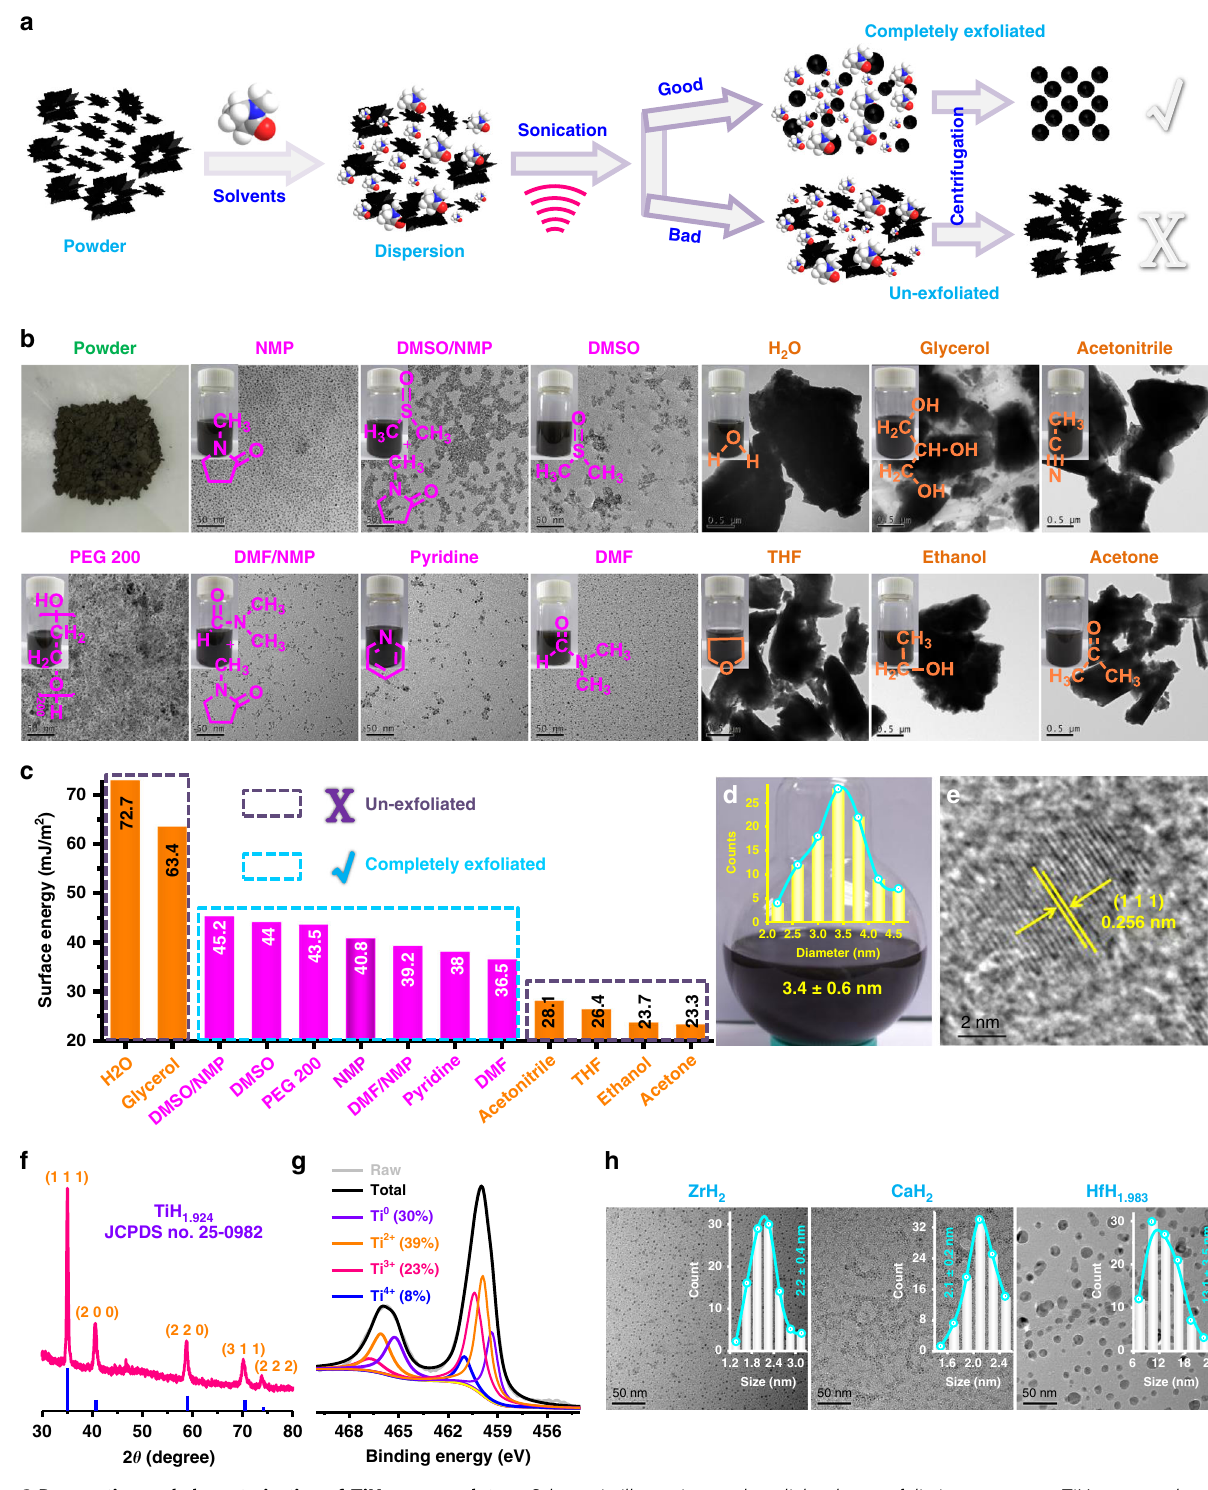
Fig. 2 Preparation and characterization of TiH 1.924 nanodots. a Schematic illustration to show light-phase exfoliation to prepare TiH 1.924 nanodots. b A photograph of commercial TiH 1.924 powder, the TEM images and corresponding photographs of exfoliated dispersions using various solvents (H 2 O, glycerol, dimethyl sulfoxide/ N -methyl pyrrolidone (DMSO/NMP) DMSO/NMP, DMSO, polyethylene glycol 200 (PEG 200), NMP, N,N -dimethylformamide (DMF)/ NMP, pyridine, DMF, acetonitrile, tetrahydrofuran (THF), ethanol, and acetone) for TiH 1.924 exfoliation. c The surface energies of various solvents used to exfoliate TiH 1.924 . d A photograph of exfoliated TiH 1.924 nanodots in NMP. Inset is the particle-size distribution (PSD) of TiH 1.924 nanodots determined by the TEM image ( n = 100 nanodots examined over TEM images). e High-resolution TEM (HRTEM) image of TiH 1.924 nanodots. f XRD spectra of TiH 1.924 nanodots. g XPS spectra to show Ti 2p peaks for the TiH 1.924 nanodots sample. h TEM images and PSD of ZrH 2 nanodots, CaH 2 nanodots, and HfH 1.983